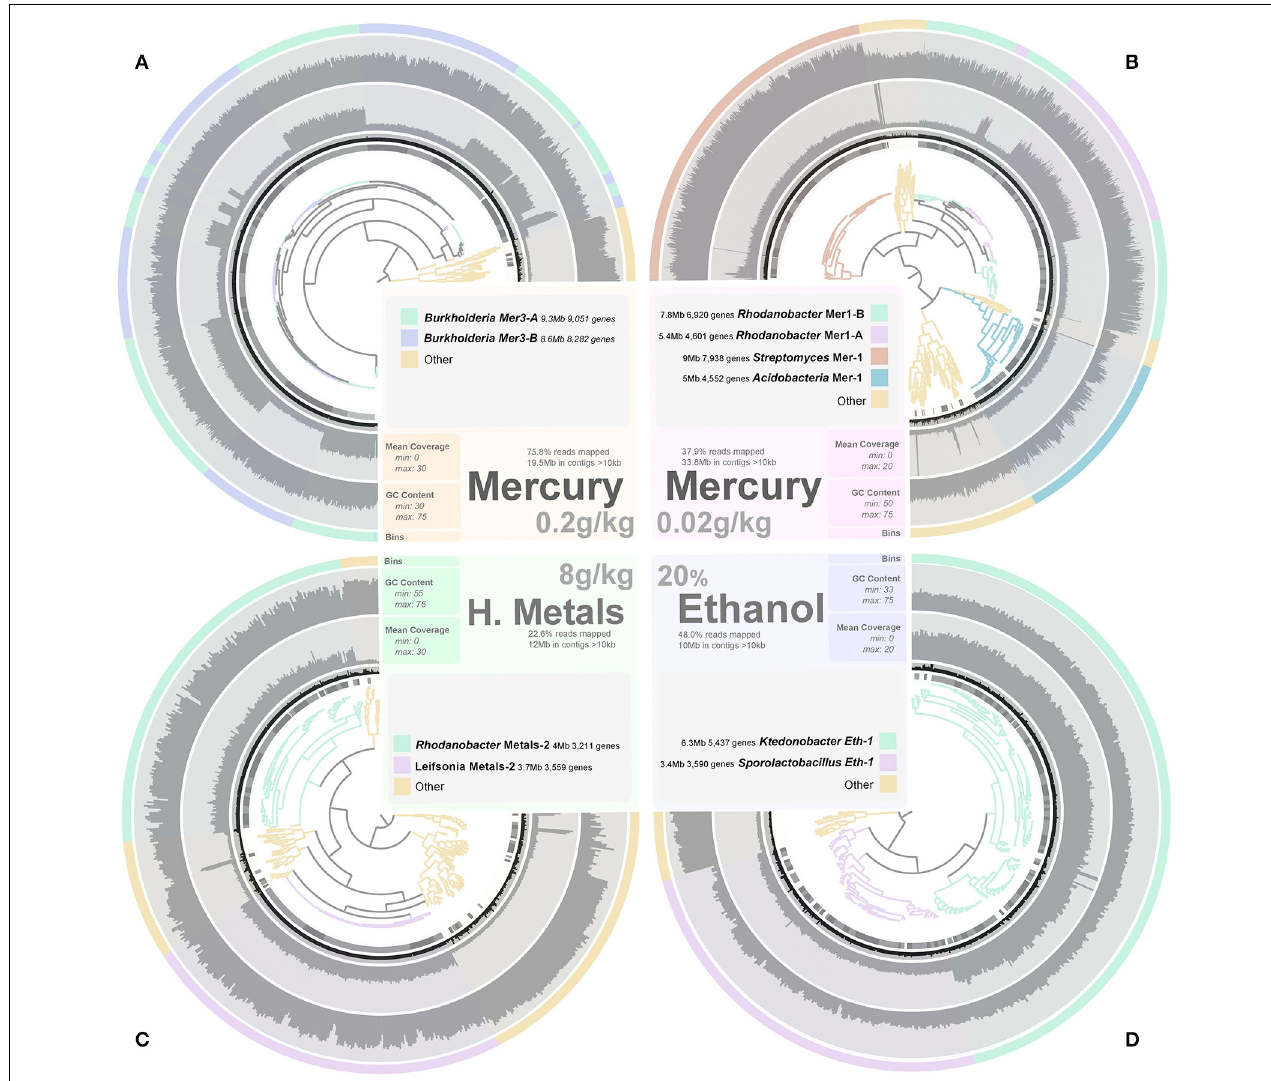
FIGURE 3 | Panels (A–D) exhibit the metagenomic assemblies (genetic structures reaching 10kb only) recovered from the Mercury enrichments 2 (19.5Mb) and 1 (33.8Mb), heavy metals enrichment 2 (12Mb) and ethanol enrichment (10 Mb), respectively. We applied